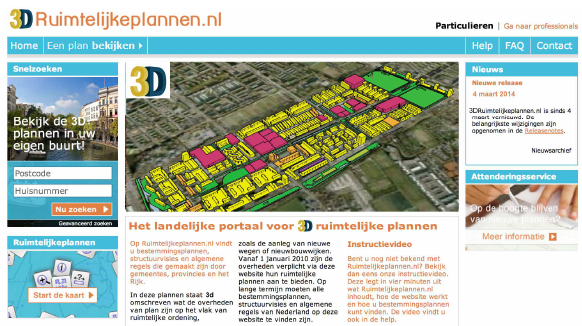
Figure 4. Mock-up of a fictional website for downloading 3D spatial plans (based on “http://www.ruimtelijkeplannen.nl”)